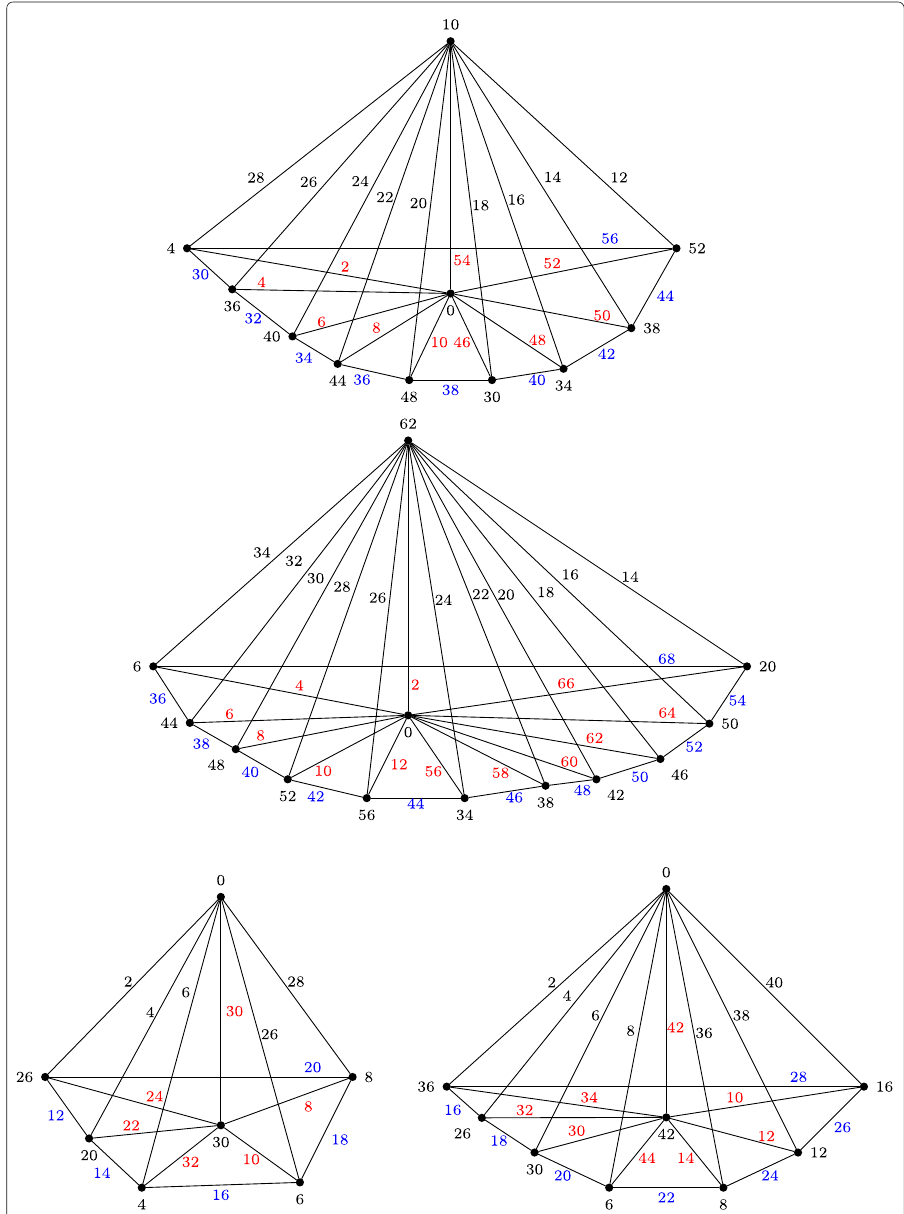
Fig. 4 An edge even graceful labeling of the graphs K 1 + W 9 , K 1 + W 11 , K 1 + W 5 and K 1 + W 7